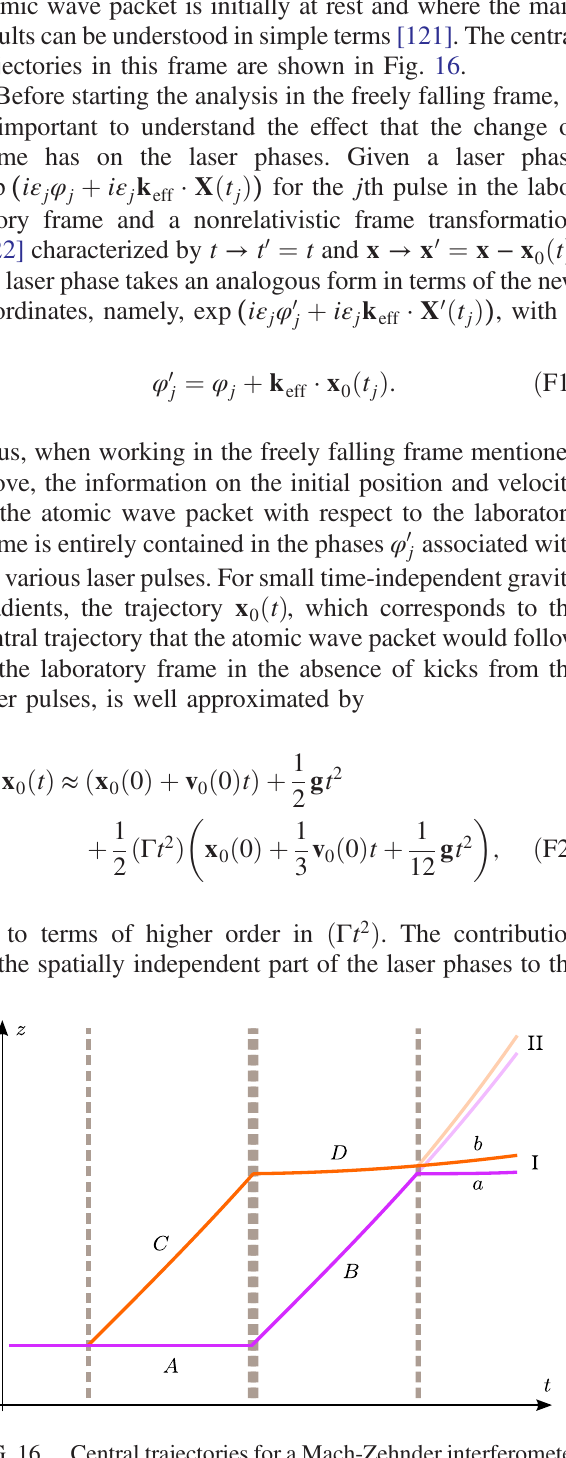
FIG. 16. Central trajectories for a Mach-Zehnder interferometer in the freely falling frame where the atomic wave packet is initially at rest at z ¼ 0 . They are no longer straight lines (except for segment A ) due to the tidal forces associated with the gravity gradient. From the figure, it is clear that the propagation phases for segments B and C are the same and so are the spatially dependent parts of the laser phases for branches a and b